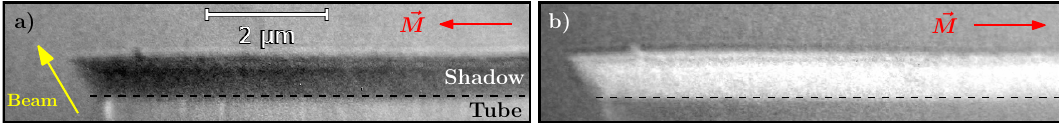
edge) of an electroless-deposited NiFeB shell Fig. 10: XMCD-PEEM images (Fe-L 3 magnetized axially sequentially along two opposite directions. The beam arrives from the bottom in a direction depicted by the arrow. Only the shadow area (in- formation from the volume) is clearly visible due to selected focus on the shadow and partial oxidation of the outer tube surface. The tube is axially magnetized with magnetization component a) parallel and b) anti-parallel to the X-ray beam. The magnetization was switched by applying 16 mT close to the axial direction (tilted with the beam). Switching field of these tubes is 10-16